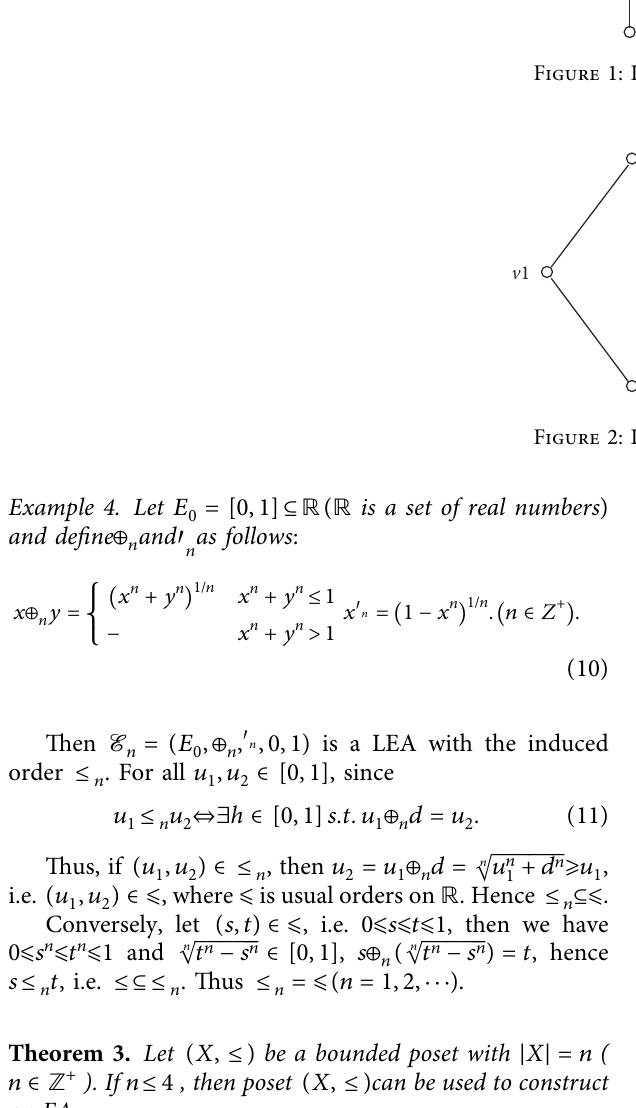
Figure 1: Lattice V